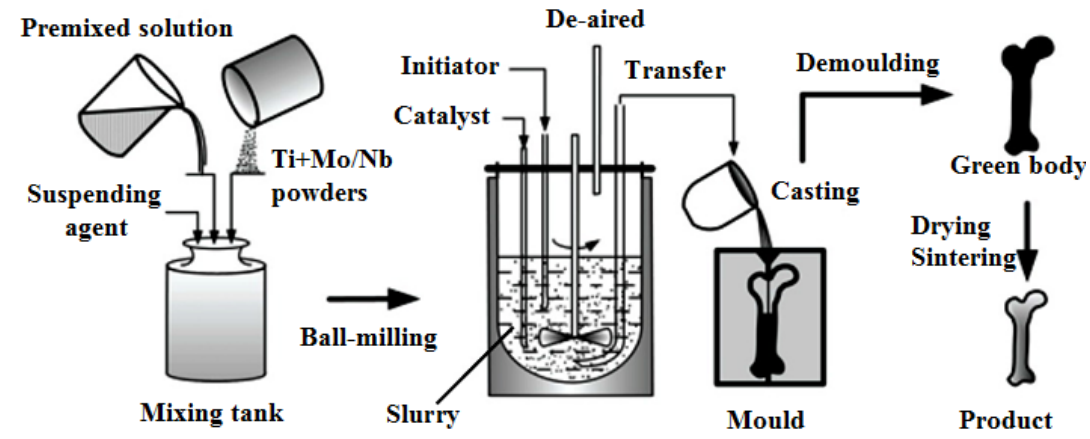
Figure 28. Schematic representation of the gel casting process [307]. Reprinted with permission from [307]. Copyright 2012 Elsevier.